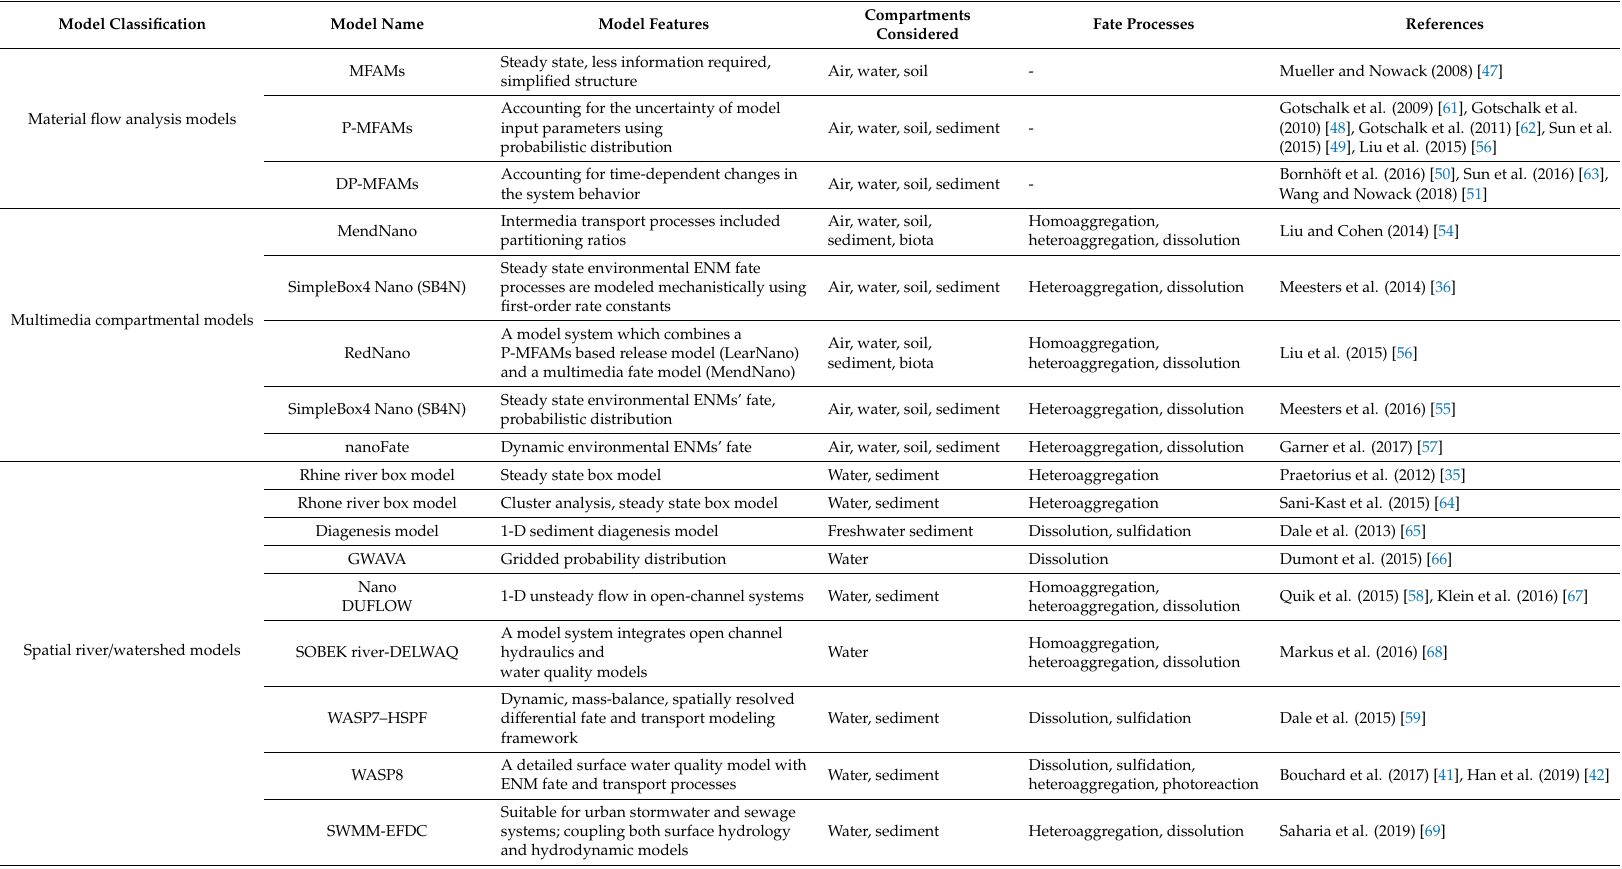
Table 1. Review of existing environmental exposure models for engineered nanomaterials